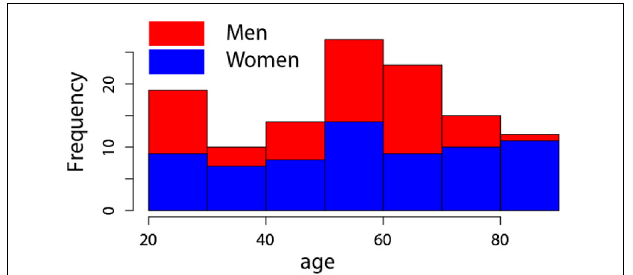
FIGURE 1 | Distribution of age, for both gender, in our sample.